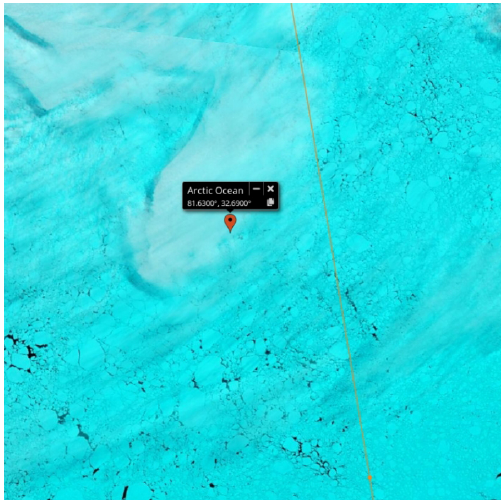
Figure C2. Same as Fig. C1, but for 2 July 2017. Image obtained from EOSDIS Worldview 2021 Version 3.15.